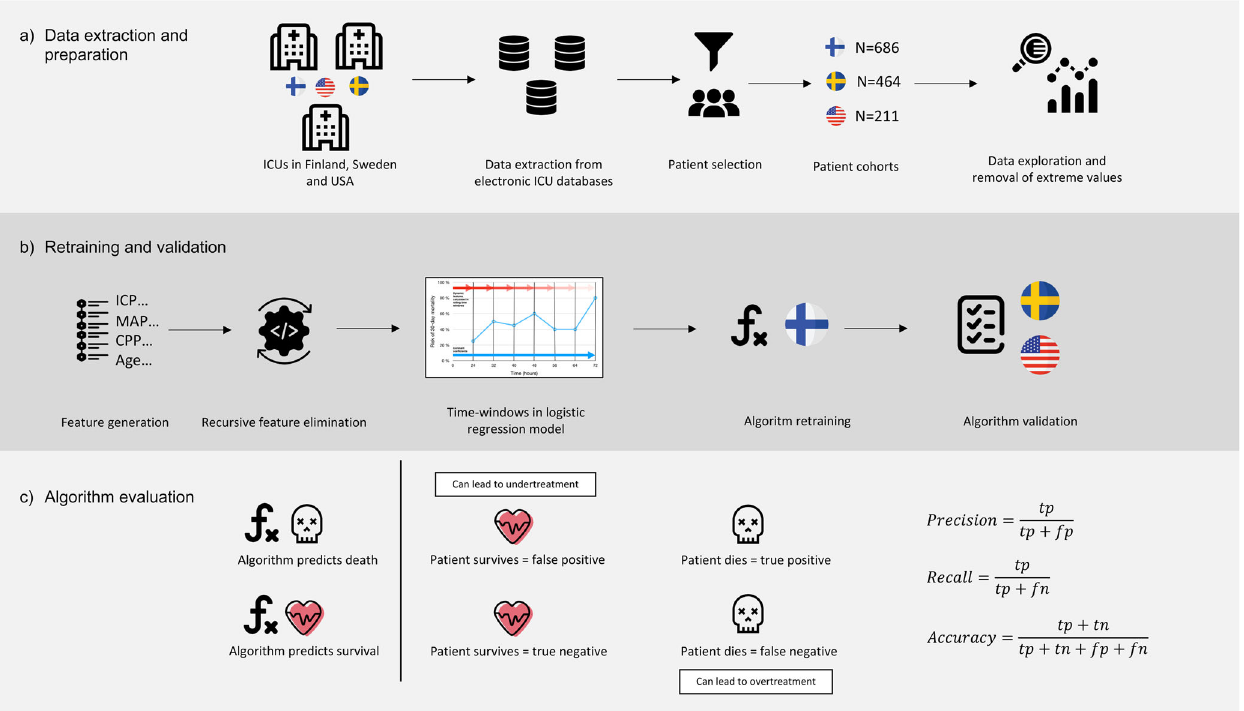
Fig. 1 Summary of the work fl ow of the data extraction, preparation, retraining, validation and algorithm evaluation. Data were extracted from the electronic intensive care unit databases. Patients were fi ltered according to inclusion and exclusion criteria before forming the fi nal patient cohorts. Data were explored and extreme measurements were removed ( a ).The model was based on intracranial pressure (ICP), cerebral perfusion pressure (CPP), mean arterial pressure (MAP) features and patient age. Following feature engineering and recursive feature elimination the fi nal features were used in a time-window-based dynamic logistic regression model. The model was retrained in the Finnish patient cohort and validated separately in the Stockholm cohort and in the eICU cohort by assessing the area under the receiver operating characteristic curve, the area under the precision-recall curve, false positives, false negatives, and accuracy ( b ). Key algorithm evaluation metrics were the rate of false positives and false negatives, prevision, recall and accuracy ( c